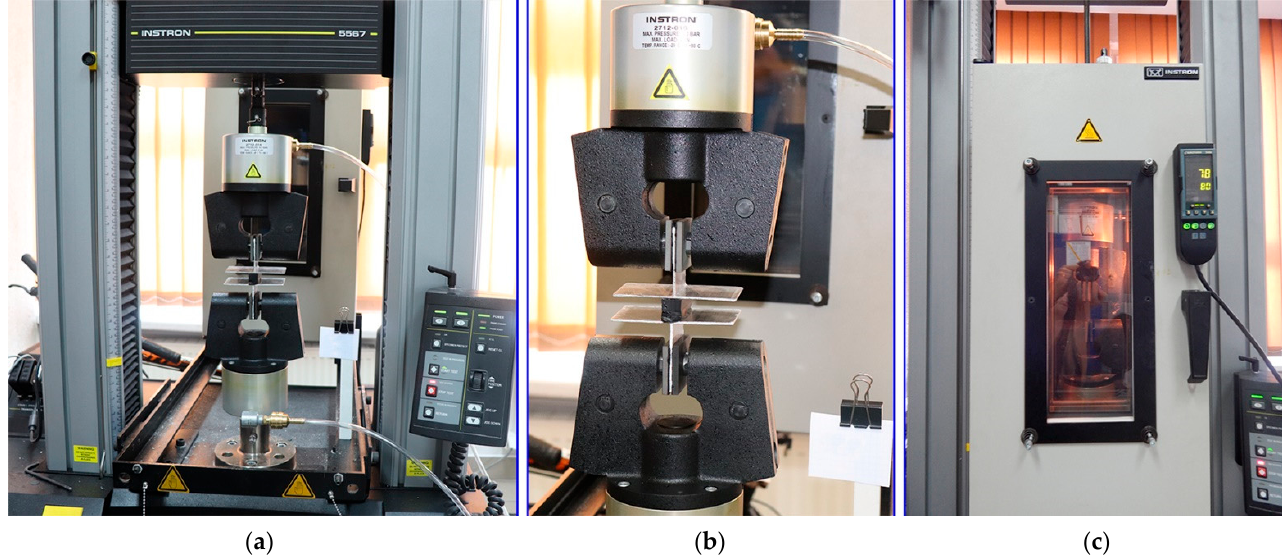
Figure 6. Determination of the properties of materials: ( a ) test frame; ( b ) pneumatic jaws; ( c ) environmental chamber.